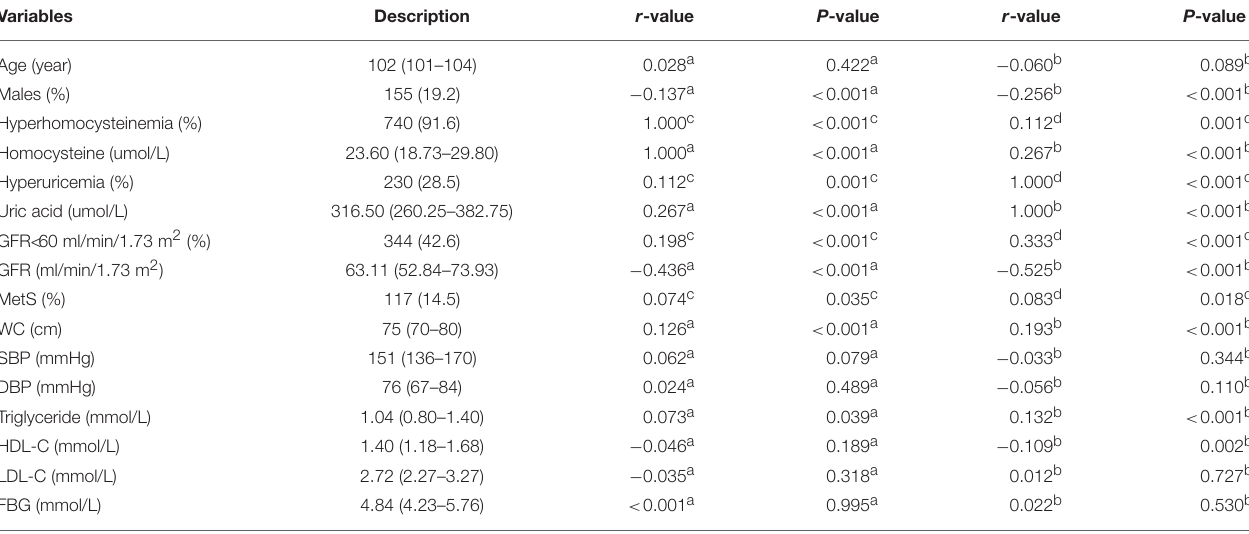
TABLE 1 | Variables of Chinese centenarians and their correlations with serum homocysteine (hyperhomocysteinemia) and uric acid (hyperuricemia) levels. Variables Description